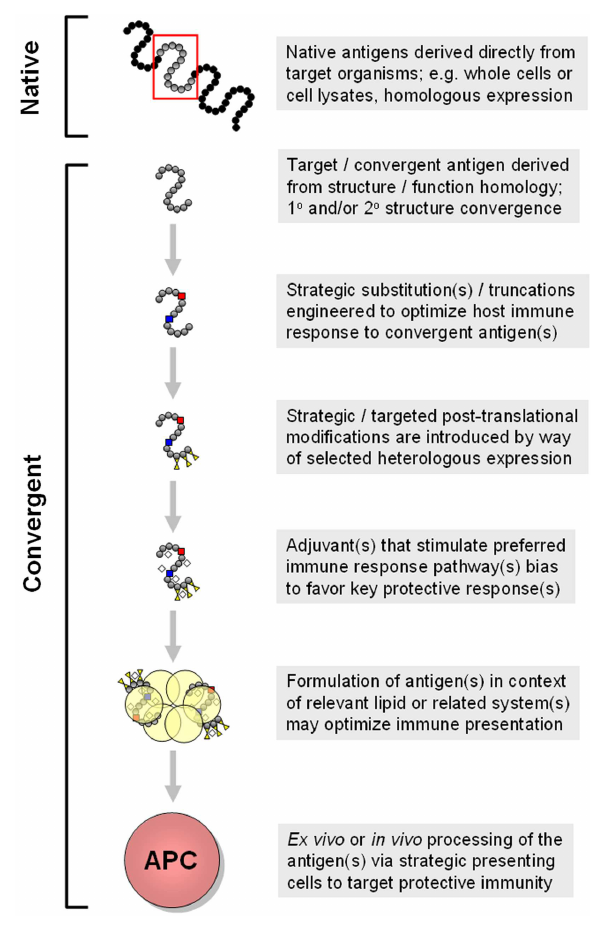
FIGURE 5 | Progressive modes for generation of convergent immunogens are shown . In this example, multiple concepts detailed in the text are shown in a sequential manner that yields increasingly strategic convergent immunogens. Approaches such as these are being employed in design of vaccines to elicit optimally protective immune responses that include tissue-targeted and cross-kingdom mechanisms of action.These and related aspects of convergent immunity may be necessary for efficacious vaccines targeting opportunistic pathogens such as S. aureus